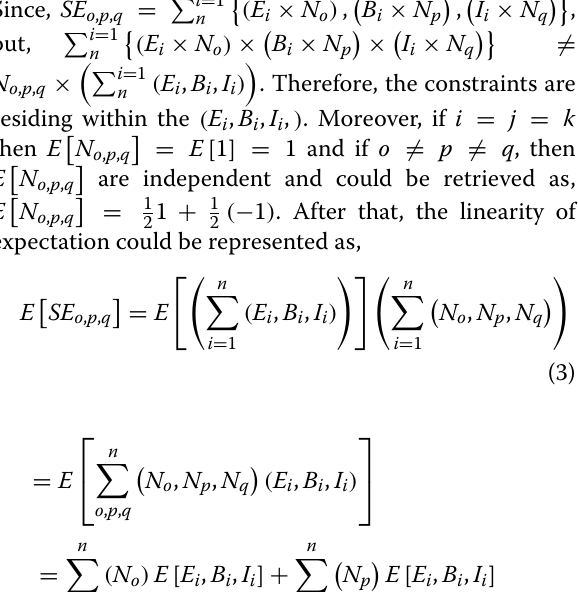
(cid:4) (cid:3) (cid:2) i = 1 × n ) , ( e b i × n p o i n